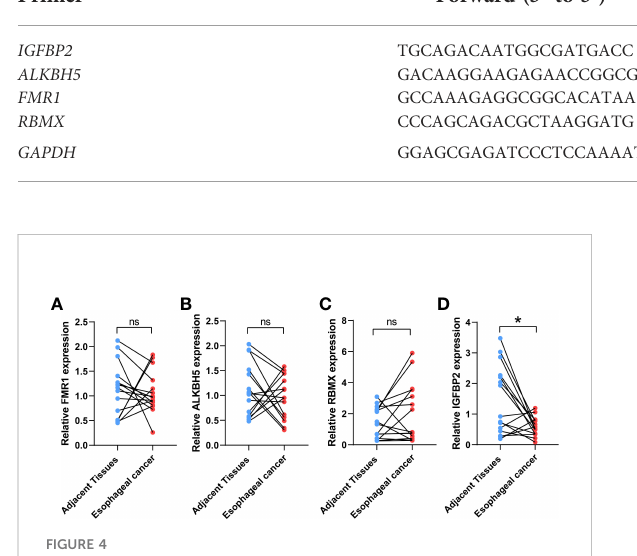
Table 1 Primers of IGFBP2, ALKBH5, FMR1, RBMX, and GAPDH. Primer Forward (5 ′ to 3 ′